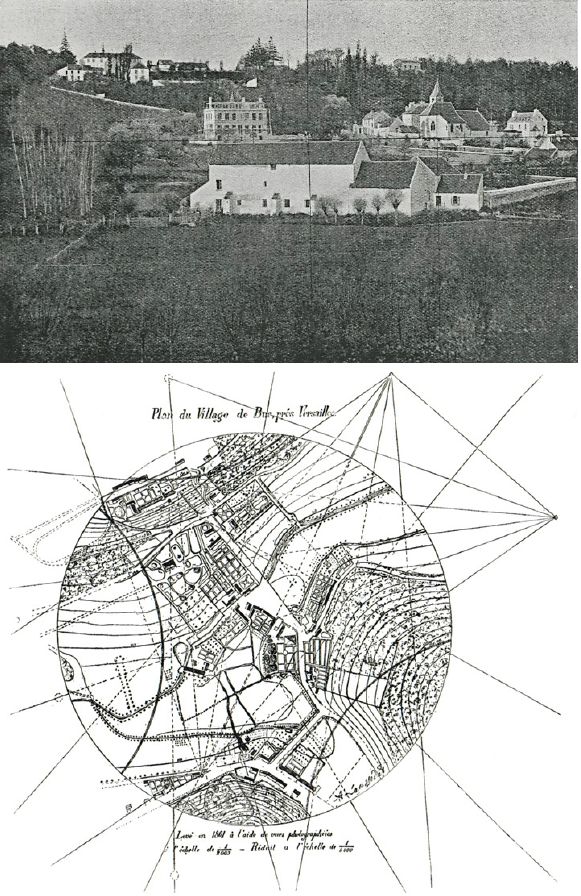
Figure 2. The Buc experiment : one of the images (above) and the map obtained by methophotography